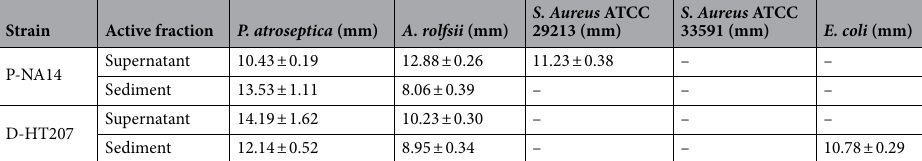
Table 2. Inhibition effect of fermentation broth of strain P-NA14 and strain D-HT207 on the different pathogens.